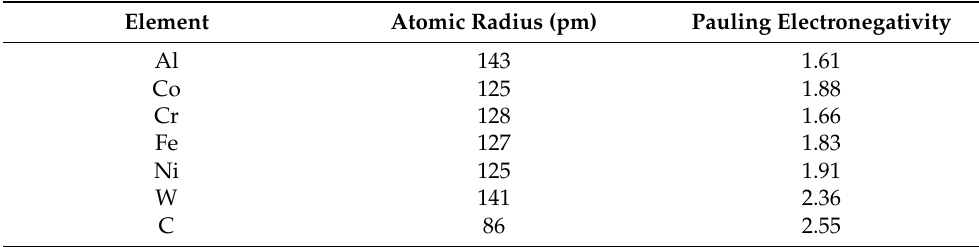
Table 2. Properties of the experimental elements (from the periodic table software). Element